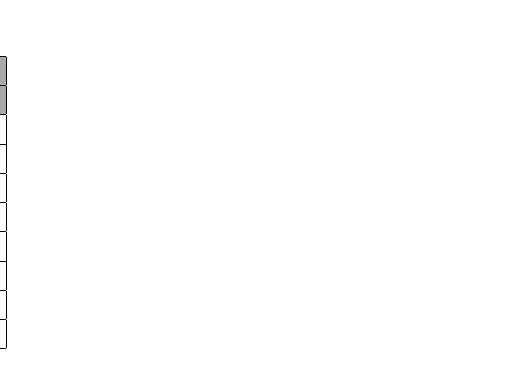
Table 2. Mean Dice similarity coefficient (DSC), 95% Hausdorff distance (HD95), and mean surface distance (MSD) between ground truth and prediction results from our tool on contrast-enhanced CT